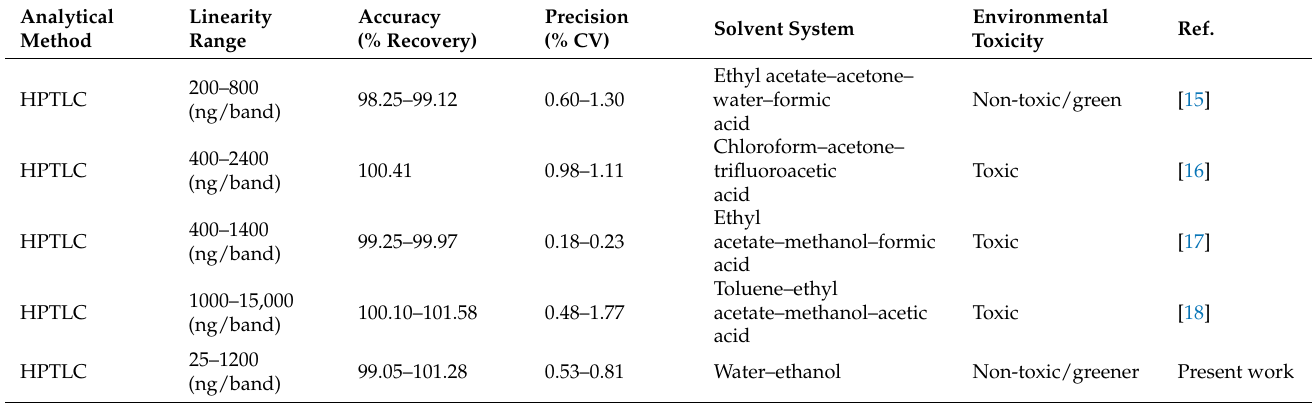
Table 7. Comparative assessment of the greener HPTLC method with reported HPTLC methods of AA